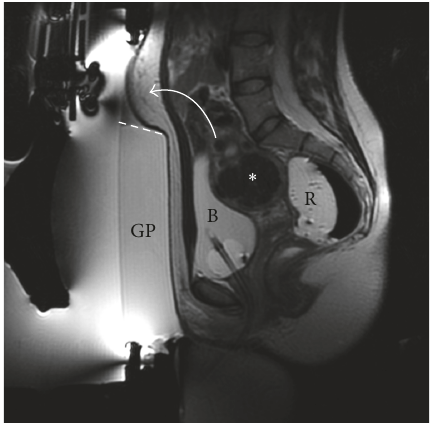
Figure 4: Case 2 : sagittal T2-w intraoperative scan showing the targeted fibroid (asterisk) and full bladder (B) with urinary catheter present. Bowels obstructing the beam path were mitigated using a custom sliced (dashed line) gel pad (GP) and rectal filling with ultrasound gel (R). Curved arrow mimics the dislocation of the bowel loops. This treatment was successfully performed through the full